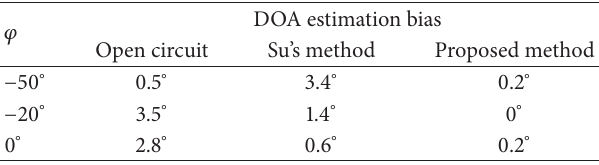
Table 2: DOA estimation bias for the linearly polarized array.